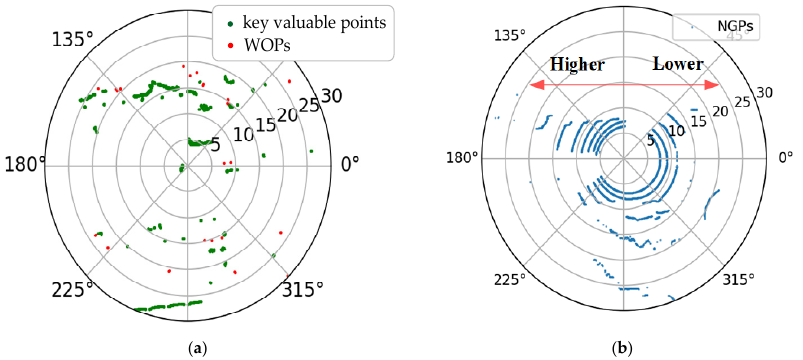
Figure 14. The key value points cluster in the key region with an inclination angle between the BGP and the projection plane. ( a ) The key valuable points in the key region. ( b ) The normal ground points in the key region.